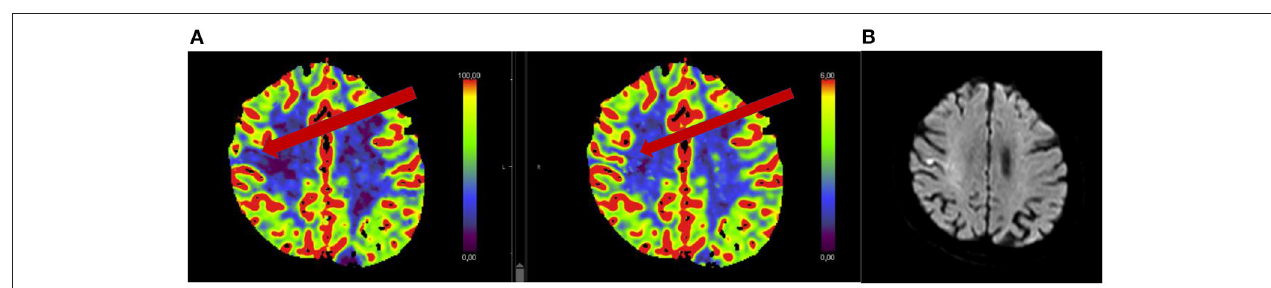
FIGURE 2 | Seventy-five year old woman with acute onset of mild left hemi-body weakness and sensory loss (NIHSS 3). Patient received intravenous thrombolysis and showed clinical improvement. Acute CT perfusion showed a mismatch between normal cerebral blood volume (B) and reduced cerebral blood flow (A) . Follow-up MRI performed 24h after thrombolysis showed a small cortical